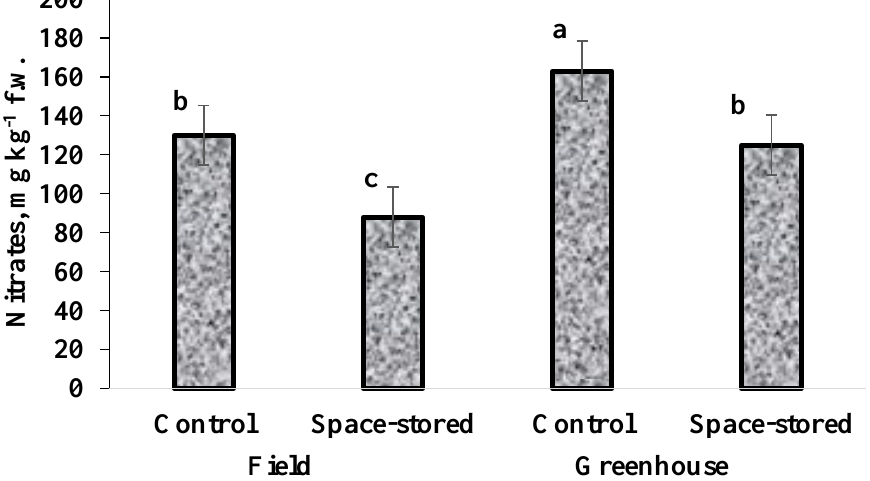
Figure 1. TDS content in tomato fruits grown from control and spaceflight-exposed seeds, in open field and in greenhouse. Values with the same letters do not differ statistically according to Duncan test at p < 0.05.